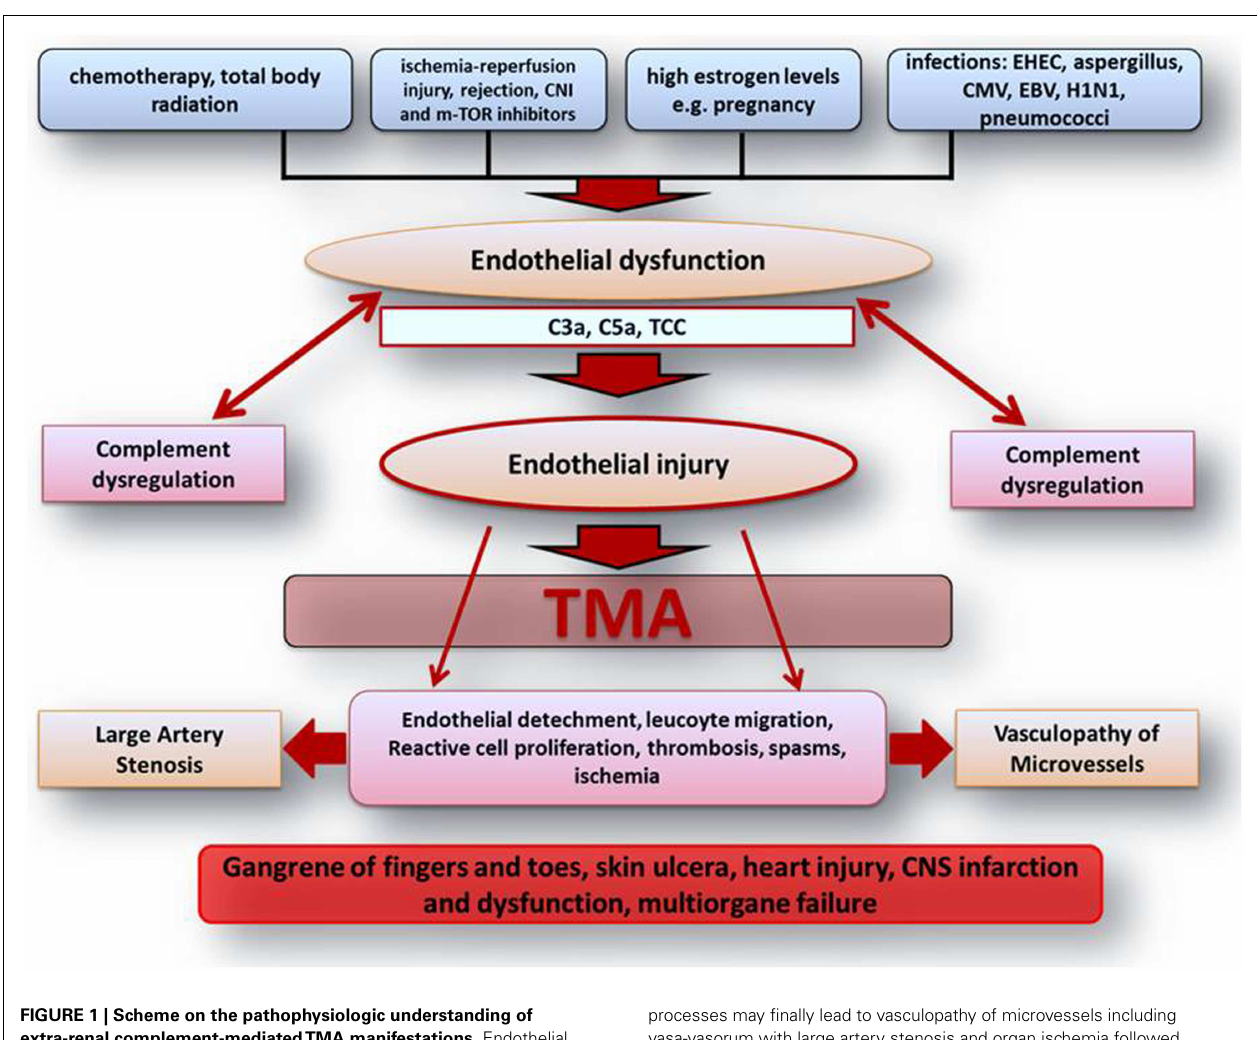
FIGURE 1 | Scheme on the pathophysiologic understanding of extra-renal complement-mediatedTMA manifestations . Endothelial dysfunction and injury represent the center ofTMA pathogenesis. Different endothelial harming factors can lead to endothelial dysfunction. Especially on the basis of inherited or acquired defects of complement regulation and activation, those factors can lead to severe complement activation inducing widespread endothelial injury with the consequence of local and systemic activation of inflammation and coagulation. All these complex complement concerted and maintained